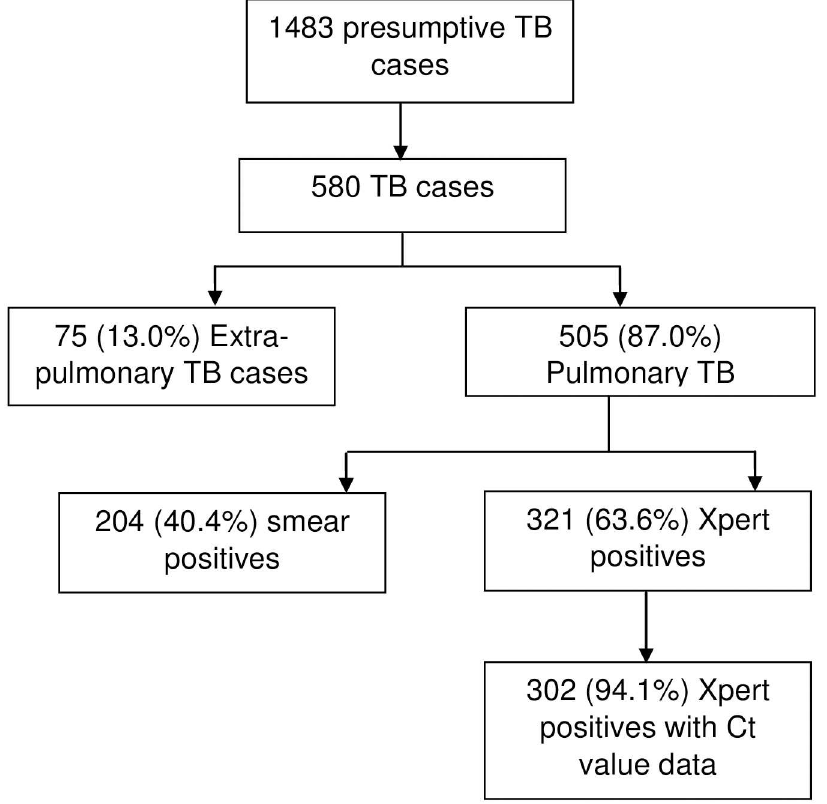
Fig 1. Flow diagramshowingXpertMTB/RIF testpositivetuberculosis participants. TB = tuberculosis, EPTB = extra pulmonarytuberculosis, PTB = pulmonary tuberculosis.